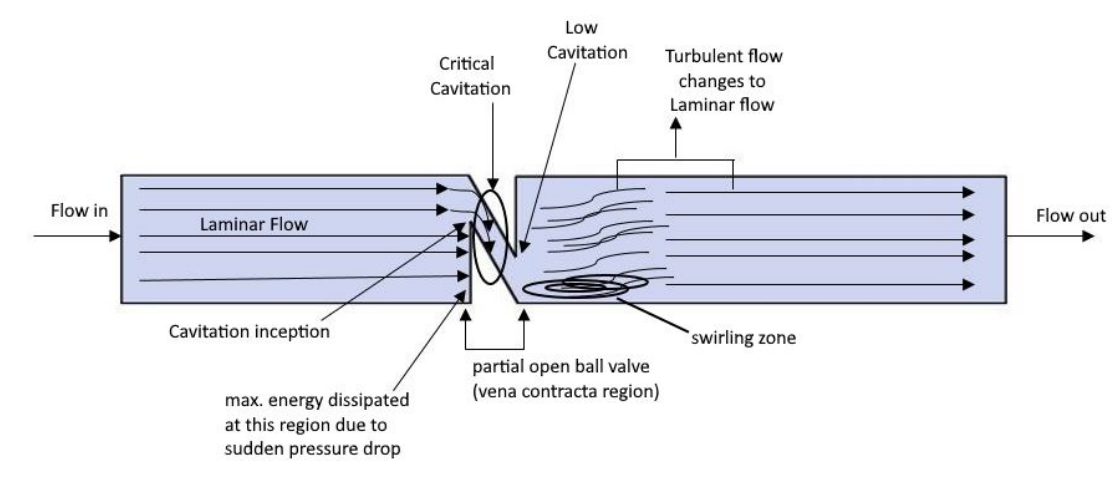
Figure 7: Conceptual design of flowing fluid through ball